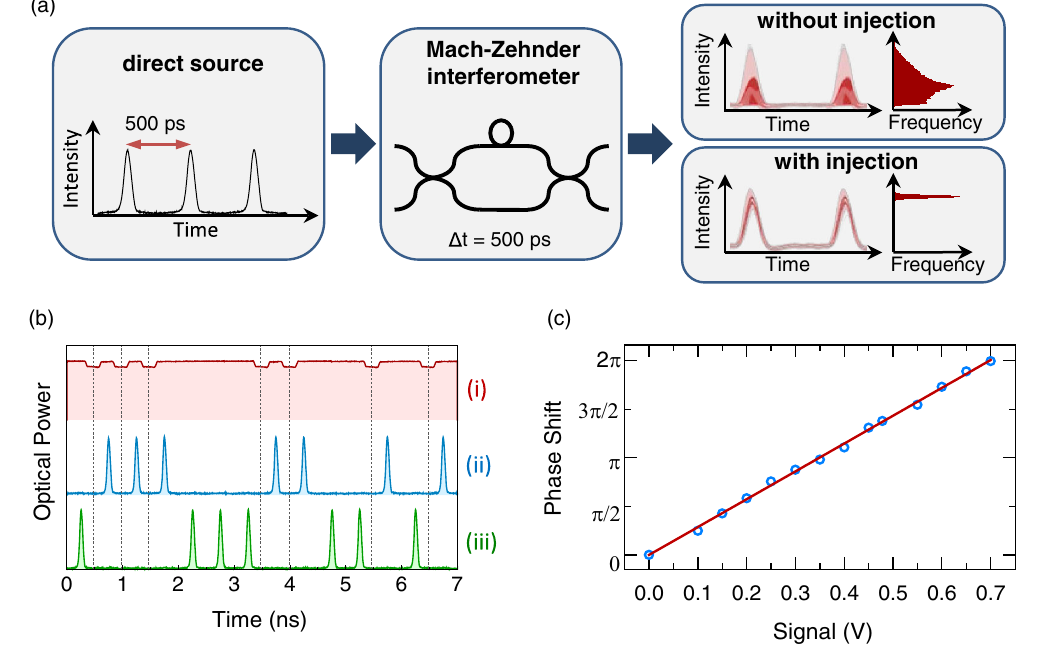
FIG. 2. Coherence seeding and phase modulation. (a) Experimental setup for evaluation of the relative phase between adjacent short pulses from the directly phase-modulated light source: The source transmits a pulse train of 500-ps intervals, and an asymmetric Mach- Zehnder interferometer (MZI) with a matching delay is used to measure the interference. Panels on the right show color-coded density plots of the measured waveforms and corresponding histograms of peak intensities for the cases with and without optical injection, respectively. (b) Demonstration of direct phase modulation: (i) Output intensity profile of the phase-preparation laser with shallow intensity modulation; (ii, iii) complementary intensity profiles recorded from the output of the MZI. (c) Phase shift as a function of the electrical signal amplitude applied to the phase-preparation laser. In (b) and (c), the modulation signal has a duration of 250 ps. An optical injection power of 50 μ W is